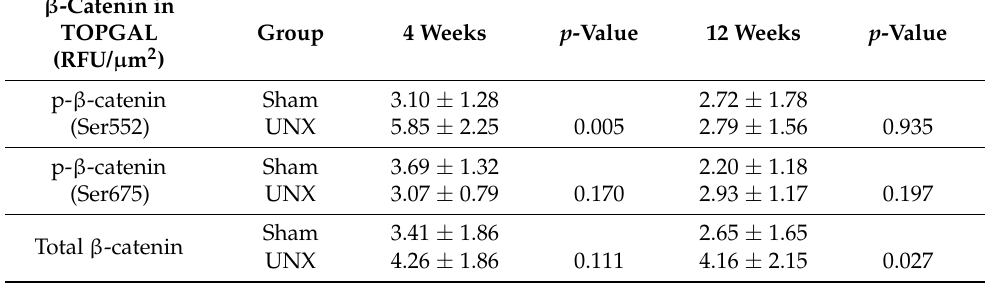
Table 3. Expression of β -catenin using immunofluorescence in TOPGAL animals at 4 and 12 weeks following unilateral nephrectomy or sham treatment at 4 weeks of age. Fluorescence measurements were performed in 3 Sham and 3 UNX animals at 4 weeks and 12 weeks. The values are shown as the mean relative fluorescence units [RFU] ± SD; the p-values were obtained using unpaired Students’ t -test.